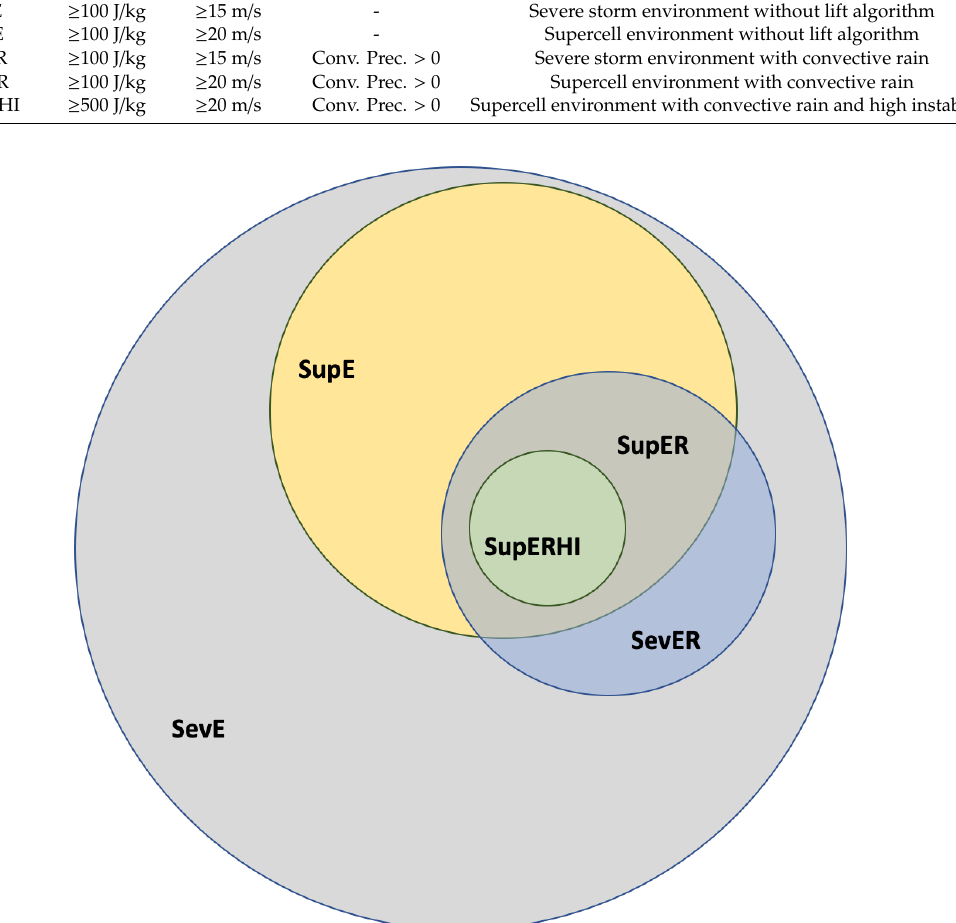
Figure 3. The proxies used in the study (definitions given in Table 1). Areas do not necessarily represent the number of cases.